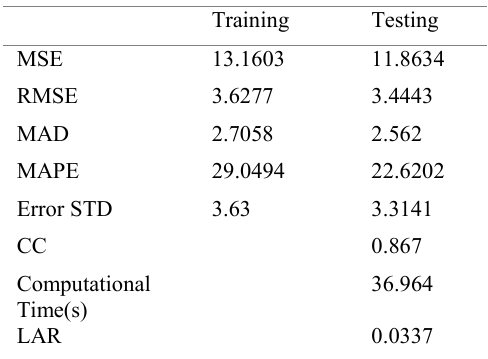
Table 4. Estimation of errors for HHV of